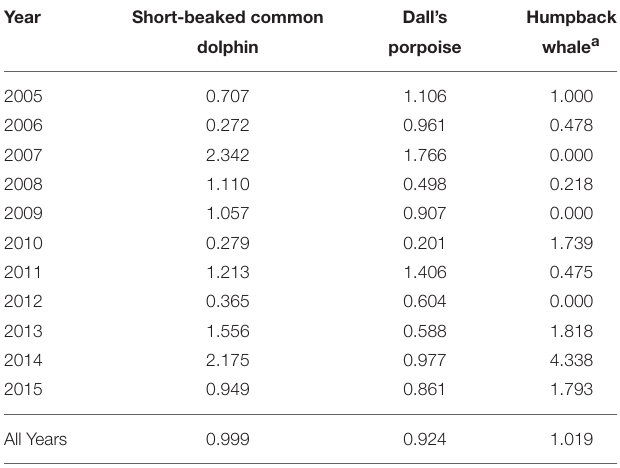
TABLE 2 | Yearly and overall ratios of line-transect over model-predicted density estimates for the total study area as calculated for each segment and summed.